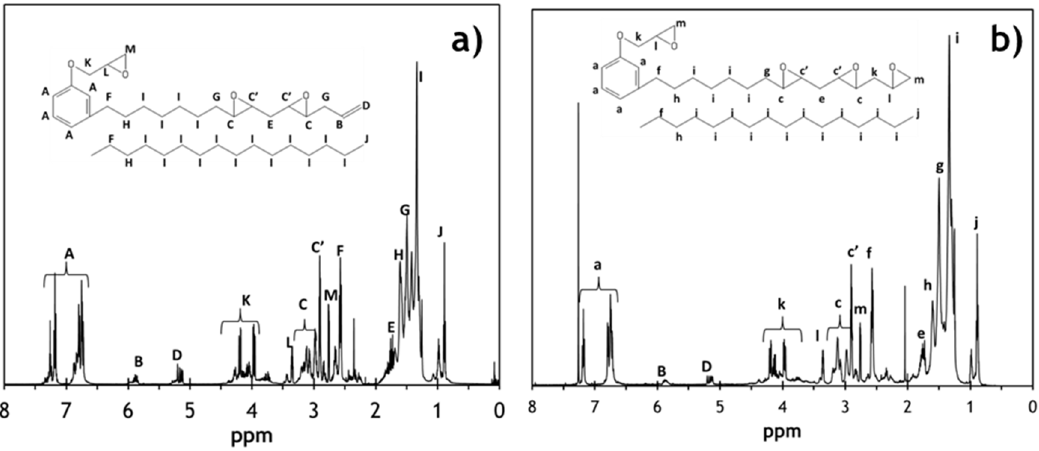
Figure 2. 1 H-NMR analysis of the reactant: ( a ) SCECGE and the product ( b )